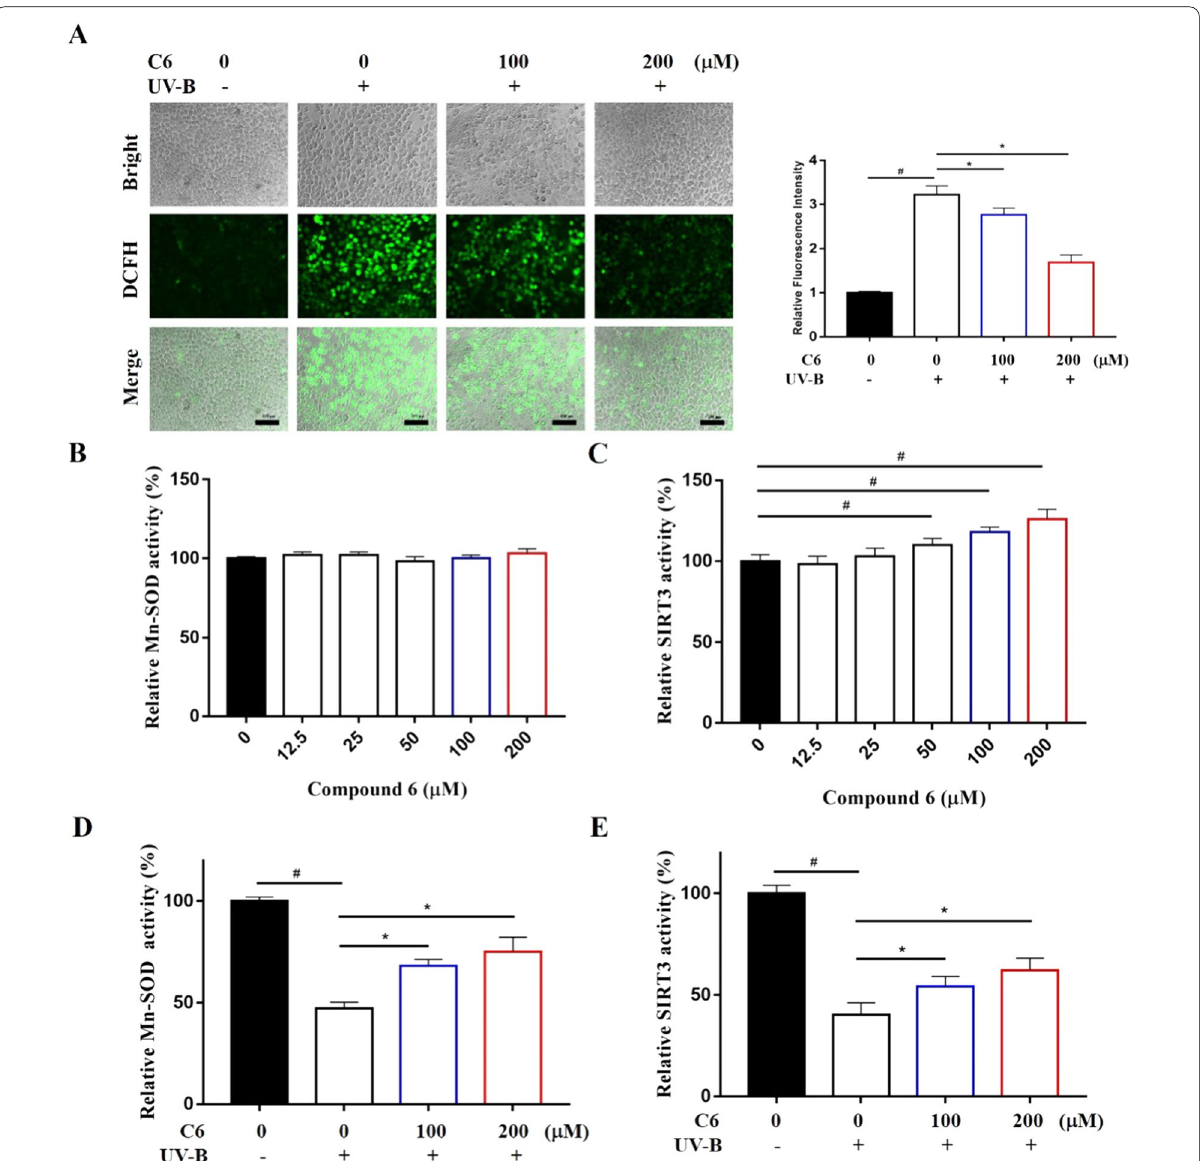
Fig. 4 Study on the mechanism of reactive oxygen species scavenging properties of bibenzyl derivatives. A Intracellular ROS scavenging performance of C6 (magnification: 20). B C6 did not directly enhance Mn‑SOD activity in vitro. C C6 directly enhances SIRT3 activity. Effects of C6 × on Mn‑SOD ( D ) and SIRT3 ( E ) enzyme activities in HaCaT cells after UV‑B irradiation. # P < 0.05, significantly different from control group; *P <